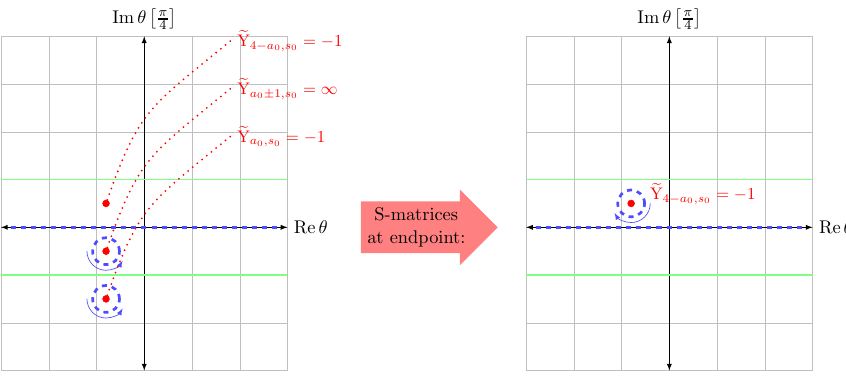
Figure 5 . Example of an analytic continuation in which the two lowest layers of the diamond shown in figure 3 cross the integration contour, while the uppermost singular point of the diamond remains above the integration contour indicated by the dashed blue line. The blue arrow indicates the orientation that the residue contributions of the crossing singularities are picked up with. The . Note that the locations of the singularity green solid line indicates the region − π ≤ Im θ ≤ π 4 4 = − 1 are within this region, but have not crossed the integration contour by assumption. e Y 0 4 − a 0 ,s 0 At the endpoint, despite several crossing singularities, only one S-matrix contribution corresponding to an effective singularity of the type e Y 0 = − 1 has to be taken into 4 − a 0 ,s 0